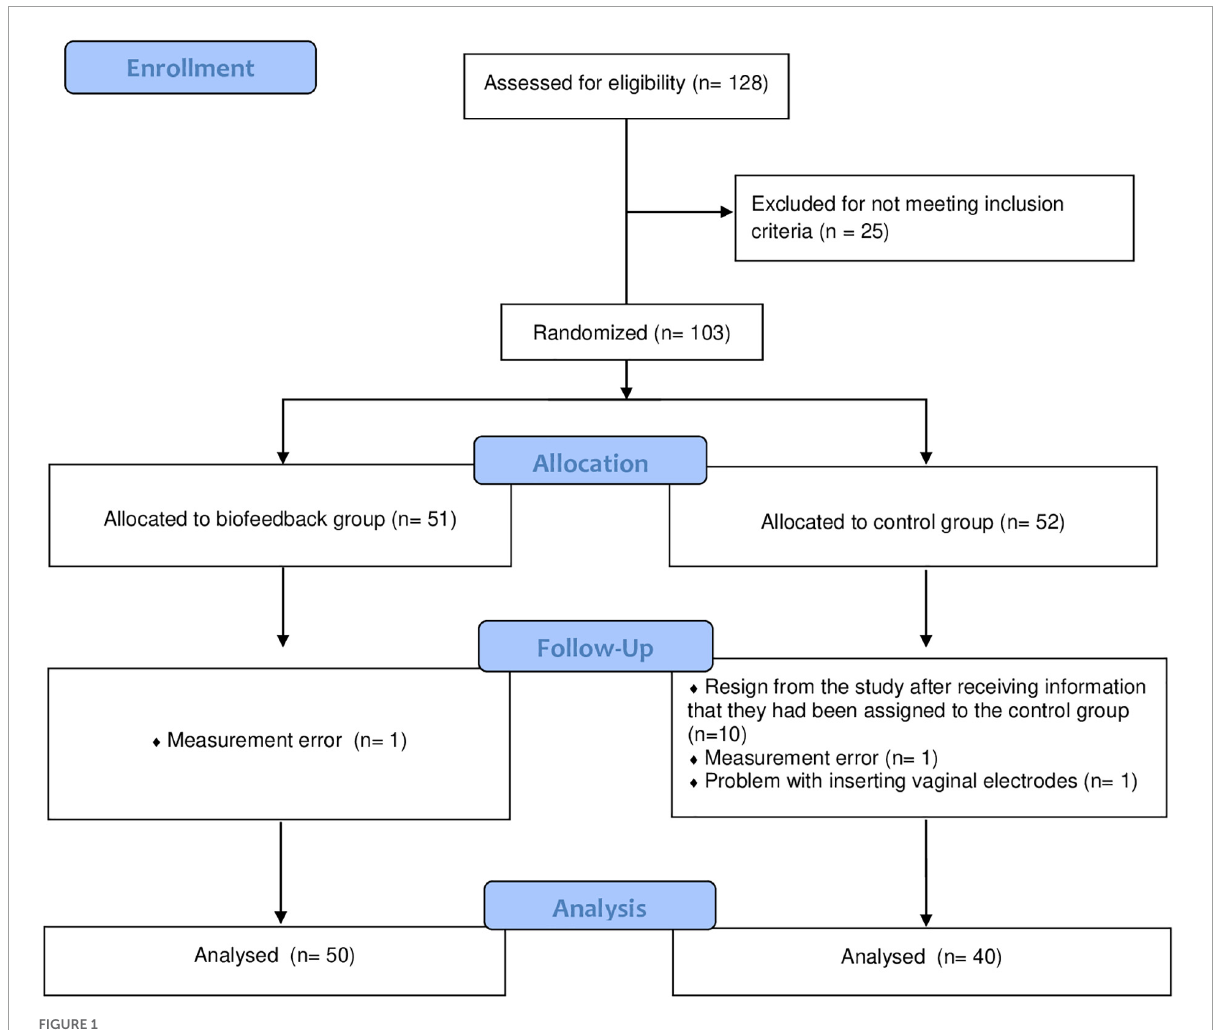
FIGURE1 The flow of participants through the